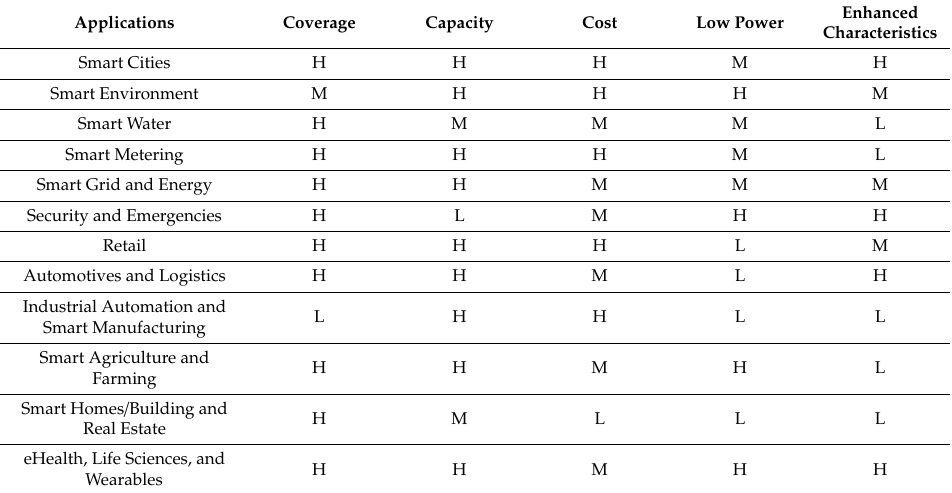
Table 2. Relevance of characteristics to applications. H, high; M, medium; L,